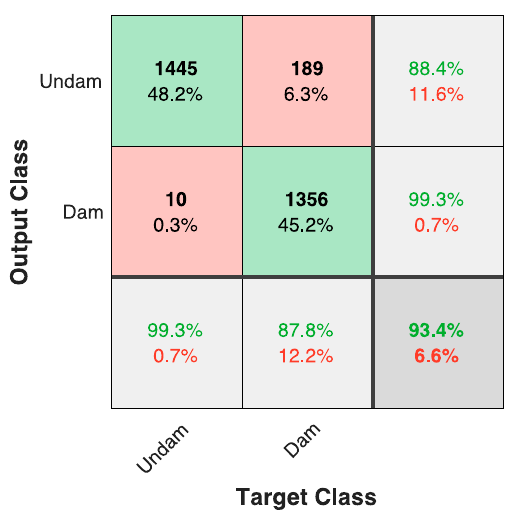
Figure 3. Example of a confusion matrix for a freq = 0.01 Hz and a rot = 0.1 ◦ . Dam and Undam refer to the damaged and undamaged structure, respectively. The percentages in the grey cells can be interpreted as “precision”, “specificity”, and so forth (check [28] for each single term).